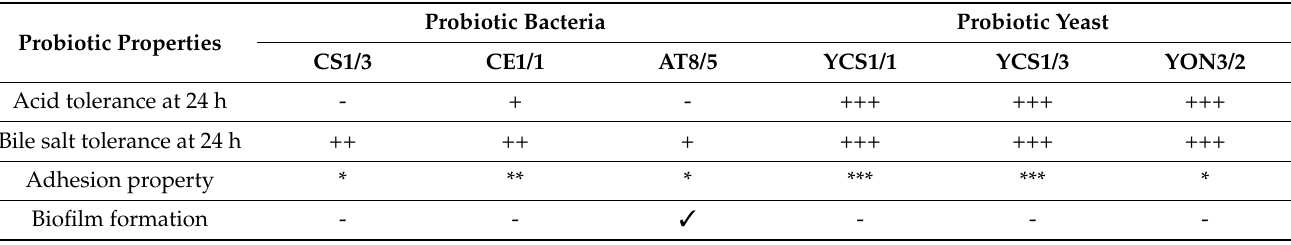
Table 4. Probiotic properties of selected isolates.